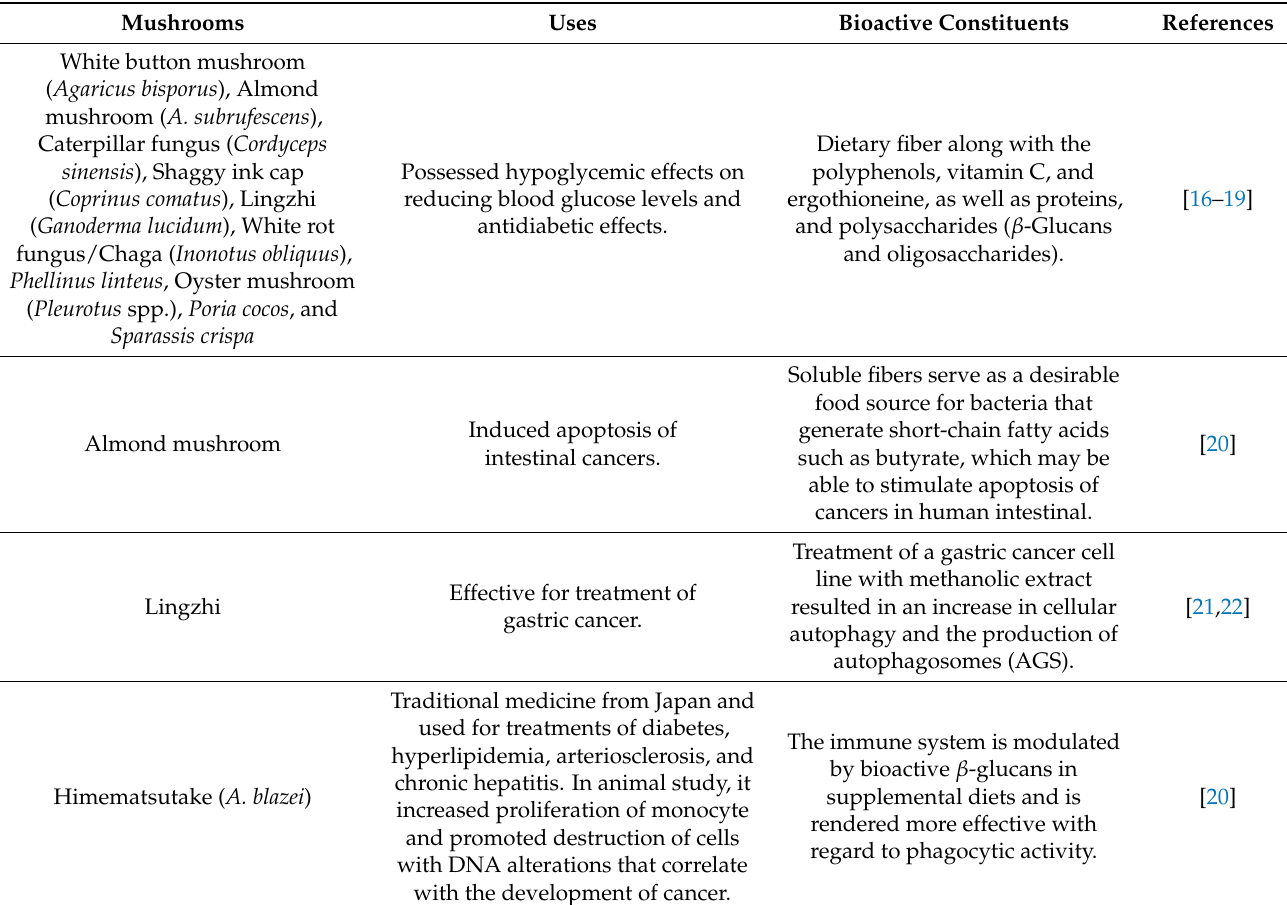
Table 1. The bioactive constituents of some medicinal